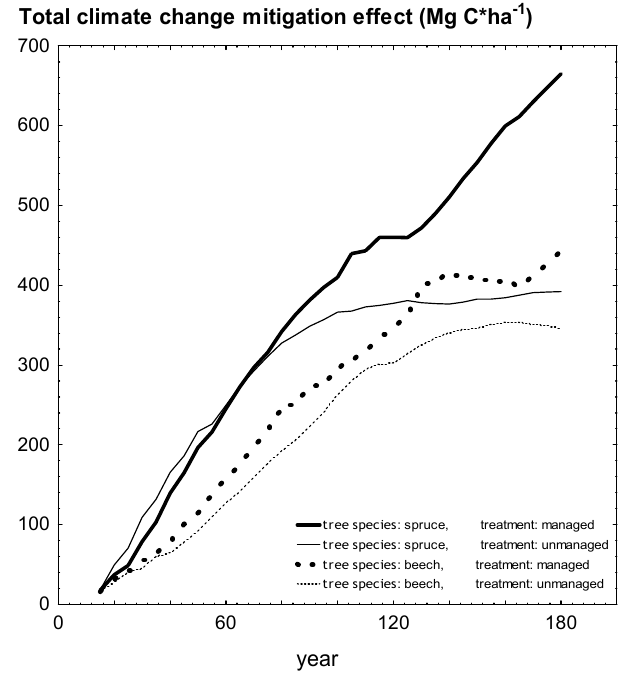
Figure 8. Total climate change mitigation effects (Mg C ha − 1 ) for spruce and beech in the managed und unmanaged